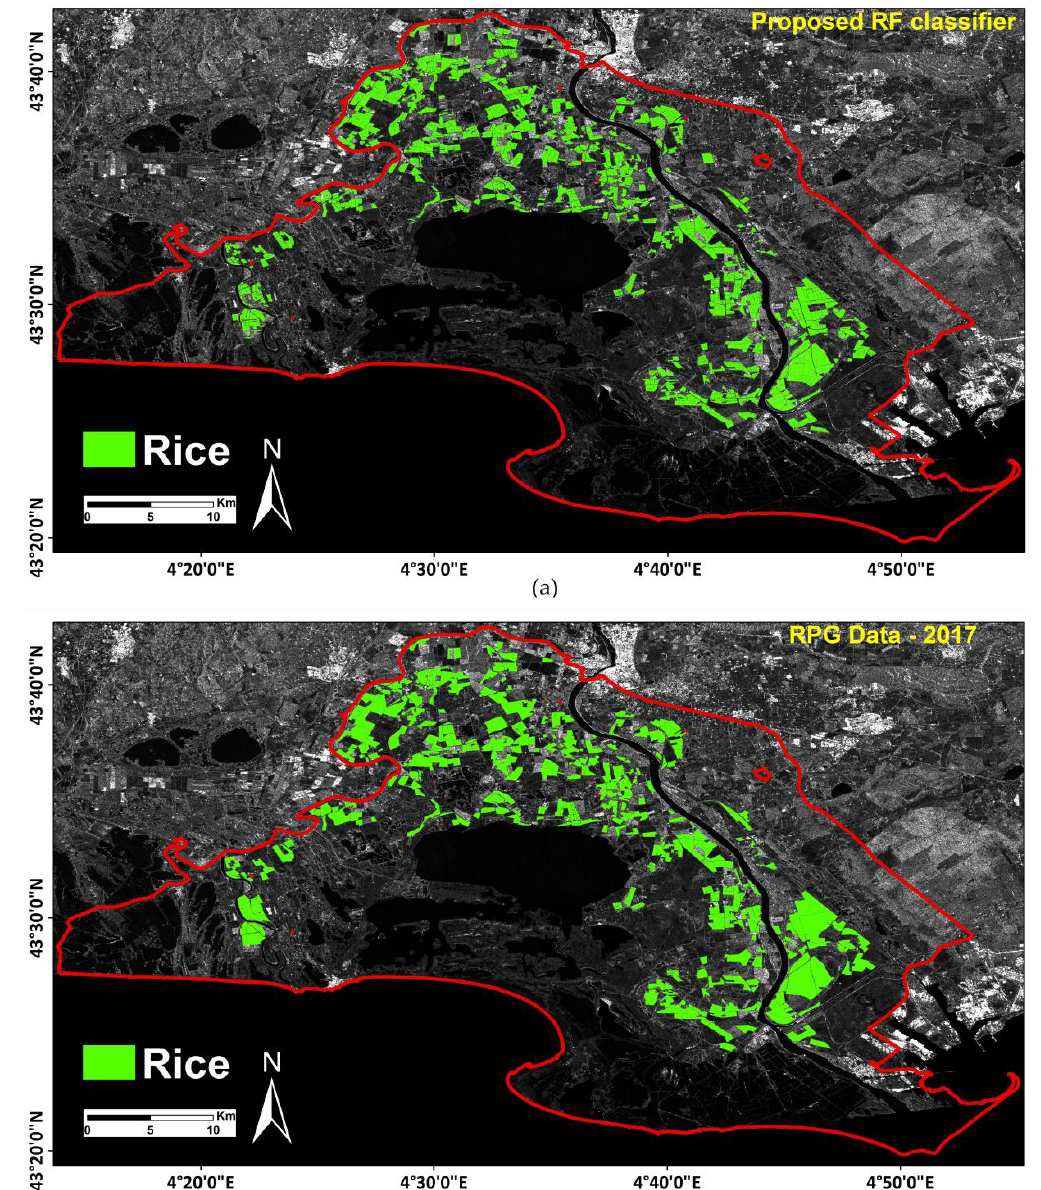
Figure 9. ( a ) Rice areas in Camargue in 2017 using our proposed RF classifier, ( b ) Rice areas in Camargue in 2017 declared by the RPG-2017. The background in both maps is a SAR image in VV polarization.